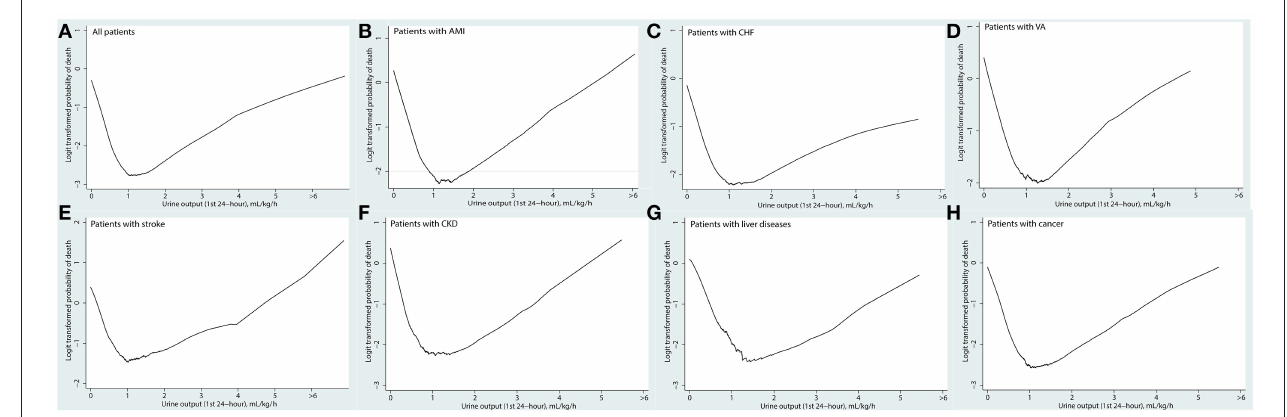
FIGURE 2 | Association between urine output in the first 24h and the 30-day mortality using the Lowess smoothing: (A) all patients; (B) patients with acute myocardial infarction; (C) patients with congestive heart failure; (D) patients with ventricular tachycardia or ventricular fibrillation; (E) patients with stroke including cerebral infarction and cerebral hemorrhage; (F) patients with chronic kidney disease; (G) patients with chronic liver diseases including chronic hepatitis and liver cirrhosis; (H) patients with cancer.